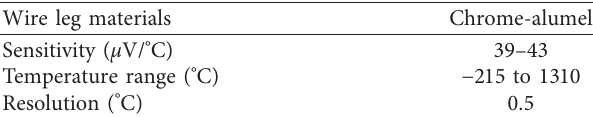
Figure 8: (a) Slots made in the piped tube (workpiece). (b) Placement of K -type thermocouple in the FSW setup. Table 4: K -type thermocouple